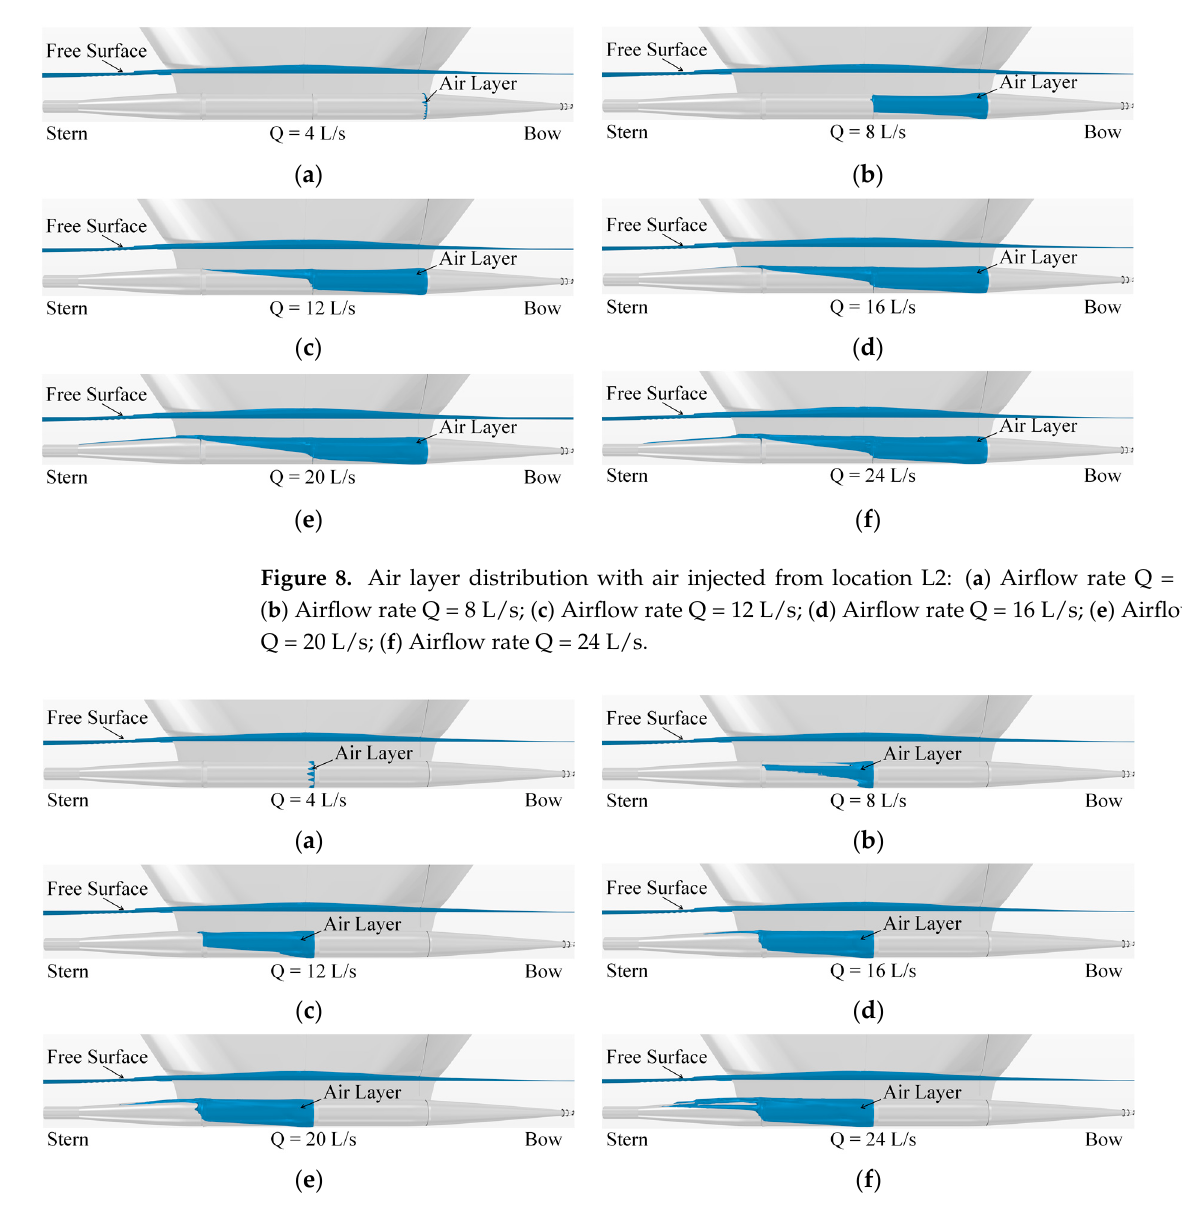
Figure 7. Air layer distribution with air injected from location L1: ( a ) Air fl ow rate Q = 4 L/s; ( b ) Air fl ow rate Q = 8 L/s; ( c ) Air fl ow rate Q = 12 L/s; ( d ) Air fl ow rate Q = 16 L/s; ( e ) Air fl ow rate Q = 20 L/s; ( f ) Air fl ow rate Q = 24 L/s.